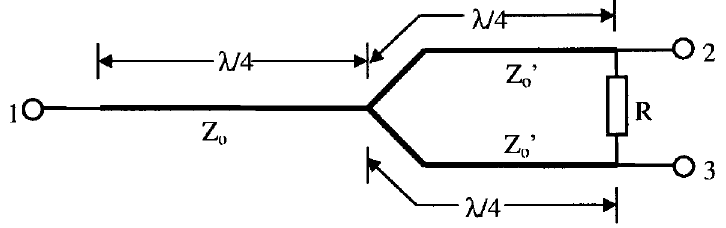
FIGURE 4 Wilkinson combiner =